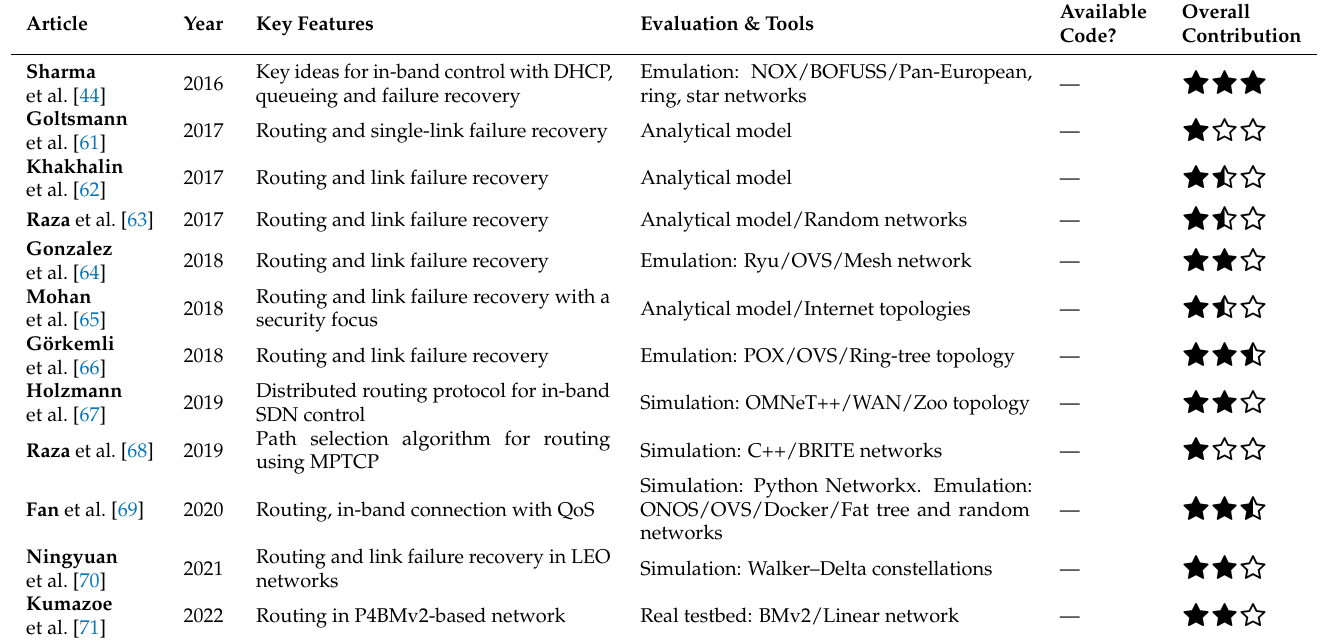
Table 2. Summary table of in-band proposals that support automatic